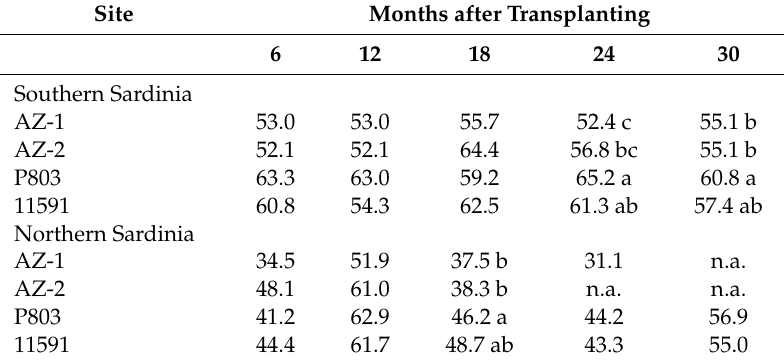
Table 5. Leaf chlorophyll content (SPAD units) of guayule lines from transplanting to harvest at 30 months at the two sites.